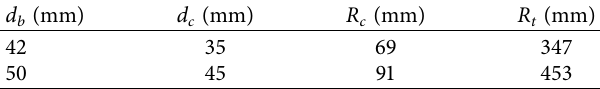
Table 3: Damage ranges for different charge diameters.